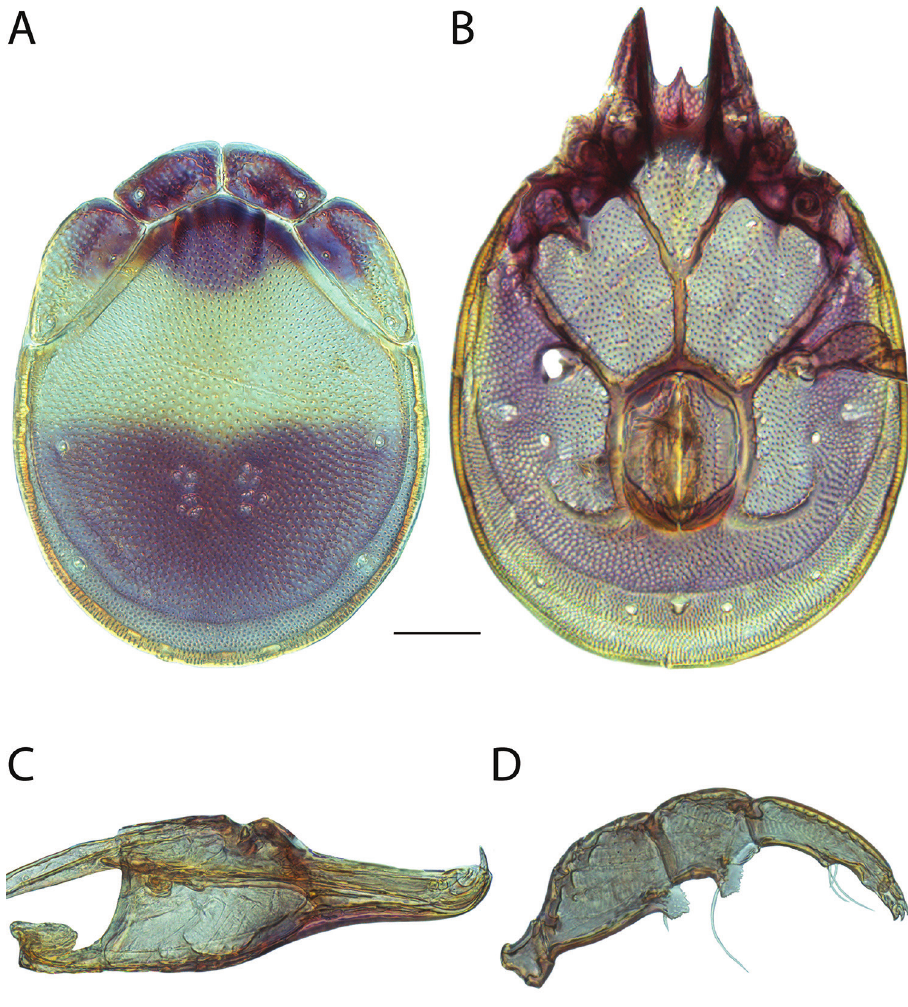
Figure 23. Torrenticola arktonyx sp. n. male: A dorsal plates B venter (legs removed) C subcapitulum D pedipalp (setae not accurately depicted). Scale = 100